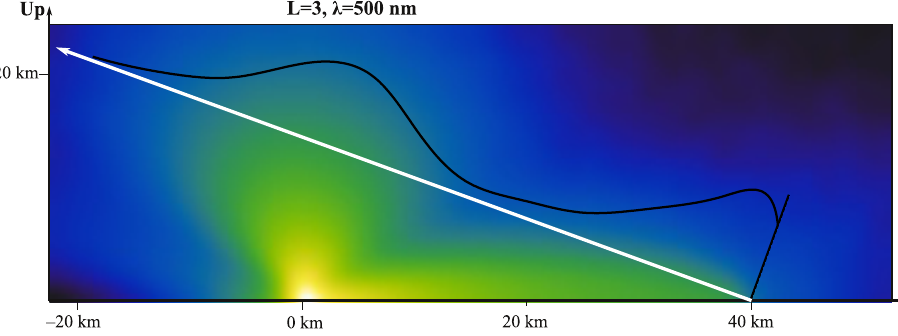
Figure 4. Section of the scattering density distribution and its variation along a line (black curve). The radiance of the sky in a given direction (indicated by the white arrow) is given by the integral of the